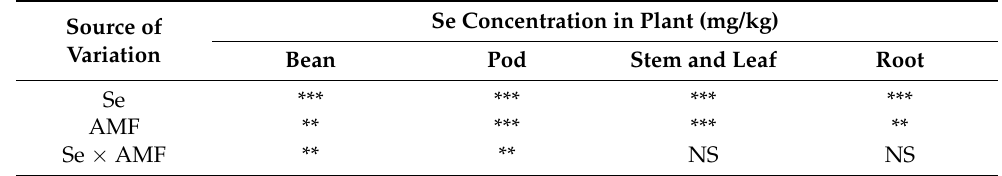
Figure 2. Effects of AMF inoculation and Se fertilizations on Se concentration in soybean organs at full maturity. ( A ) Seeds, ( B ) pods, ( C ) stems and leaves, ( D ) roots. NM indicates the treatment without AMF, Ce indicates Claroideoglomus etunicatum , Fm indicates Funneliformis mosseae . Within each column, data presented are the means ± SE of three independent pot replicates. Data with different letters reveal significant differences in the same color column ( p ≤ 0.05). Table 2. Significance of main treatment effects and their interaction on Se fertilizer application and AM fungus